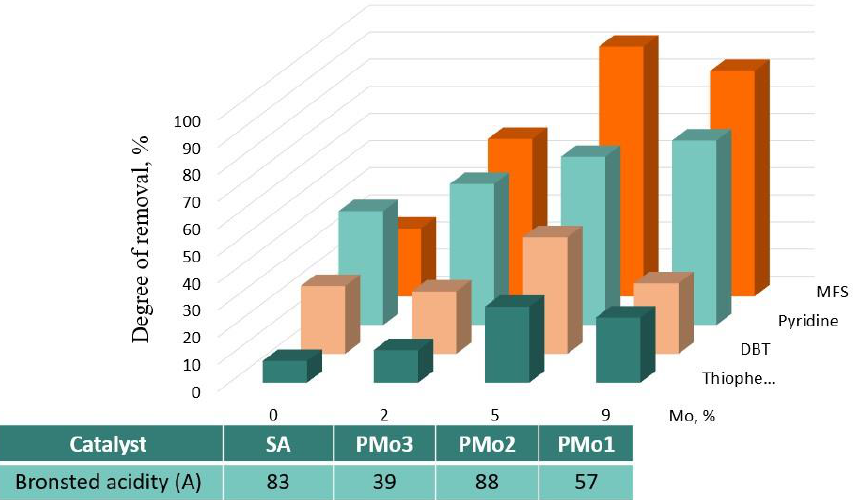
Figure 11. Influence of acidity and metal content in catalysts on substrates removal in 1 h (MFS 30 min).